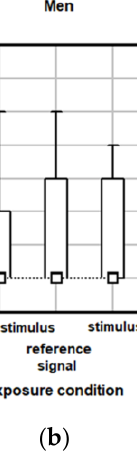
Figure 7. Total numbers of post-exposure ailments reported in various exposure conditions by ( a ) female and ( b ) male students. Data are given as median values with 5th, 25th, 75th and 95th percentiles.